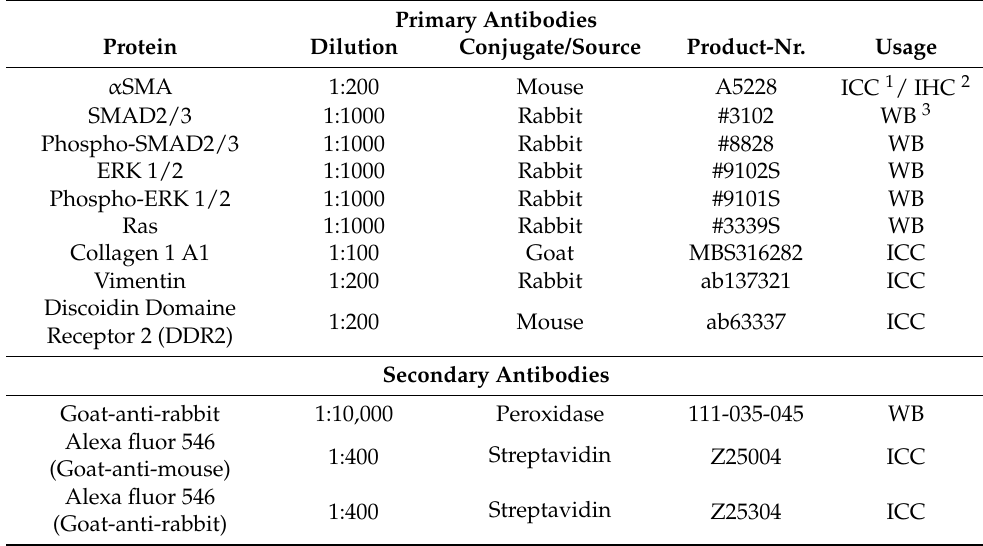
Table 2. Primary and secondary